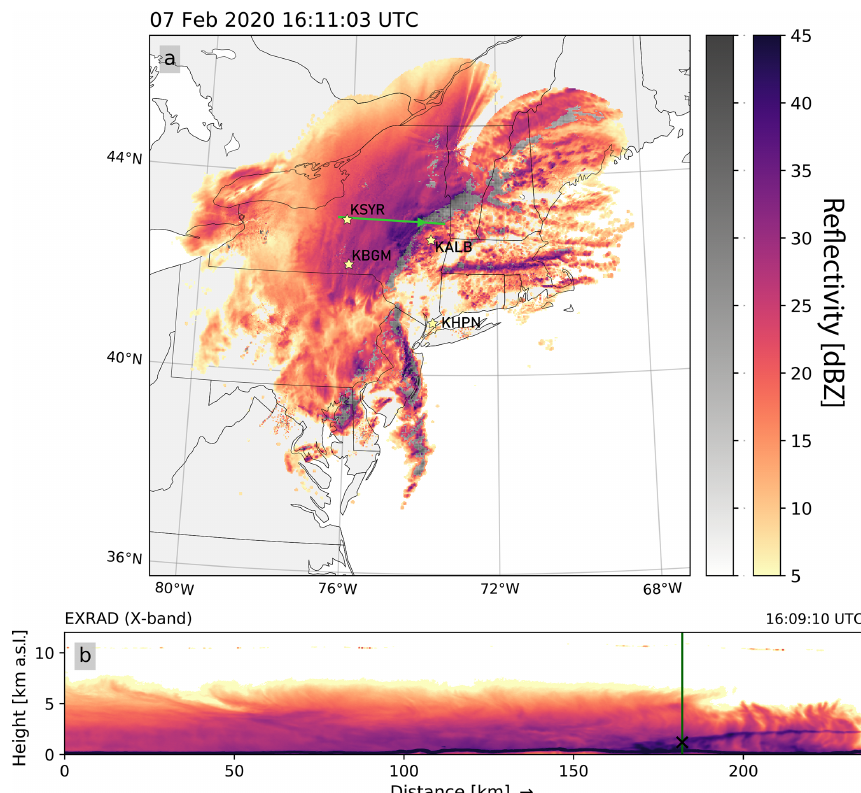
Figure 2. Comparison of image-muted regional map with detailed vertical cross-section from NASA ER-2 X-band Doppler radar during a NASA IMPACTS science mission on 7 February 2020. At 16:09:10UTC, the aircraft is located at the transition between snow and melting precipitation in the radar regional map. (a) Image-muted reflectivity valid at 16:11:03UTC with the ER-2 flight leg (green line), aircraft location corresponding to the time shown in the bottom panel is at the arrowhead along the leg. Locations of ASOS observations in Fig. 4 are annotated with stars and black labels. (b) Vertical cross-section of reflectivity from the NASA EXRAD radar with current aircraft location near the top of the vertical green line. Time on the right corresponds to the aircraft position. The black X indicates the height of the point in panel a that varies along the 0.5 ◦ elevation angle scans used to construct the regional maps. An animated version of this figure (Animation- Figure-2) is in the Video